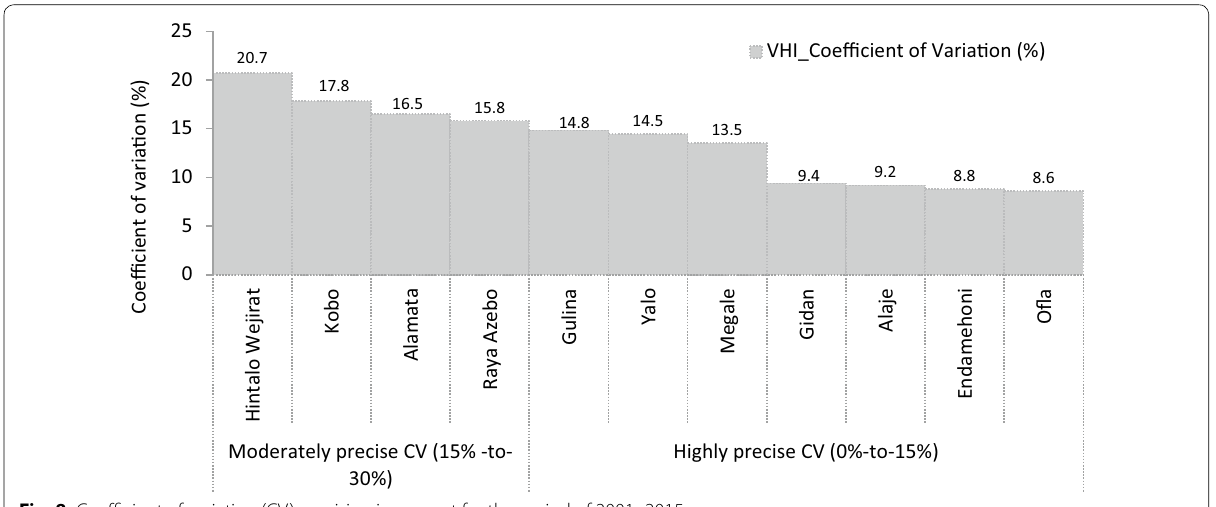
Fig. 8 Coefficient of variation (CV) precision in percent for the period of